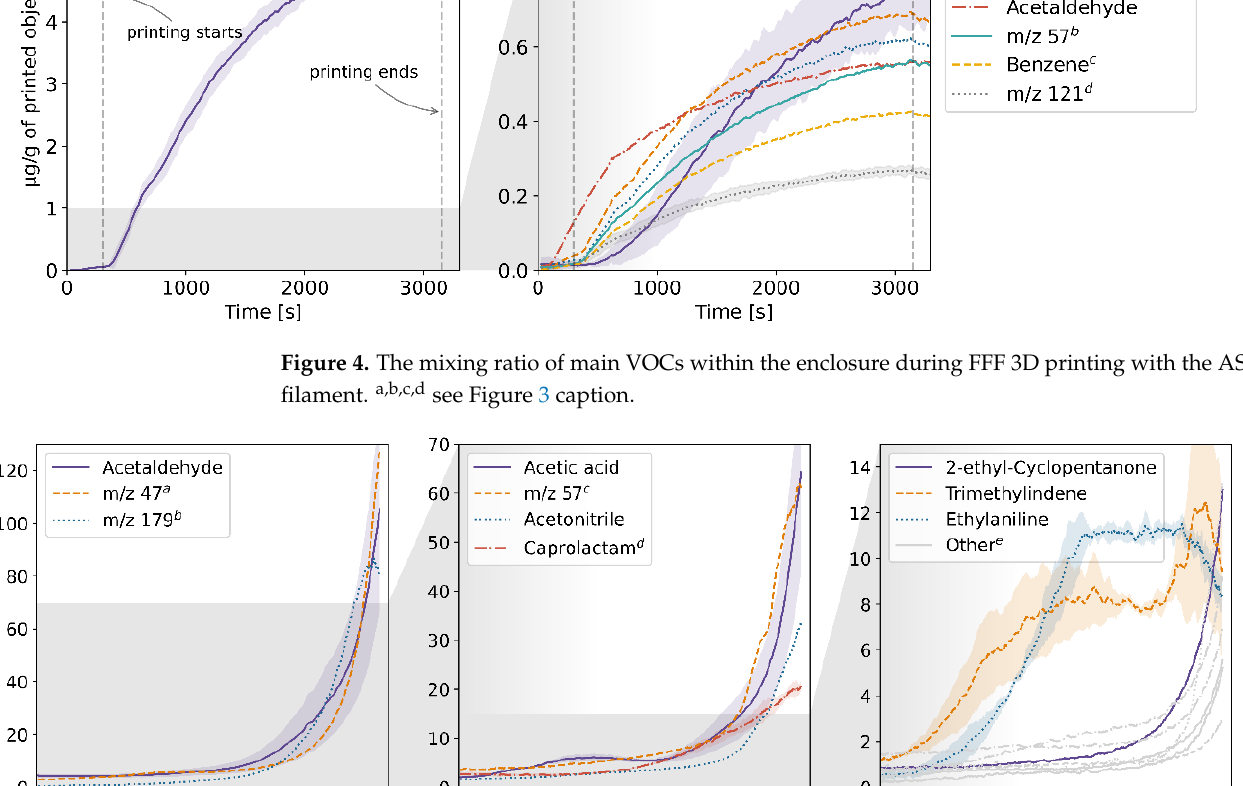
Figure 5. Temperature-dependent emission profile of the Nylon filament. a unidentified, possibly